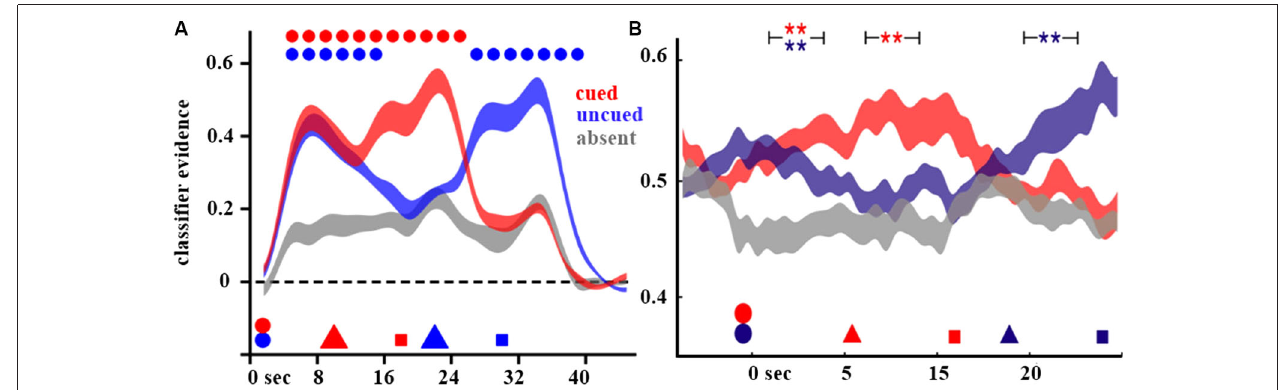
triangles indicate the cues, and squares indicate the memory probes). The color scheme indicates the categories with respect to the cues: cued (red) is the category indicated by the first cue, uncued (blue) is the category of the other stimulus which is not selected by the first cue, and absent (gray) is the category not present on that